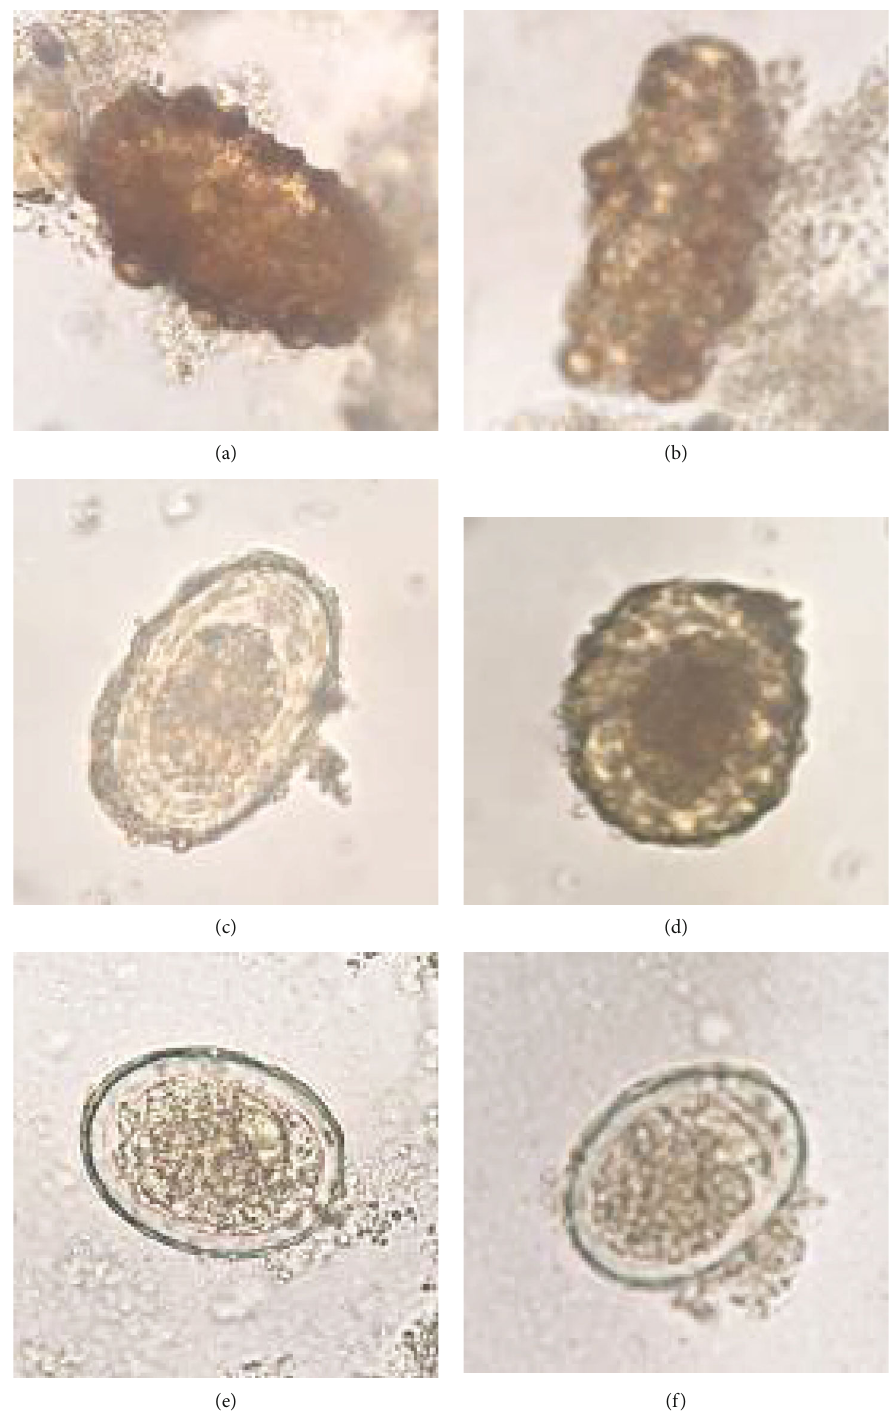
Figure 4: The three types of A. lumbricoides